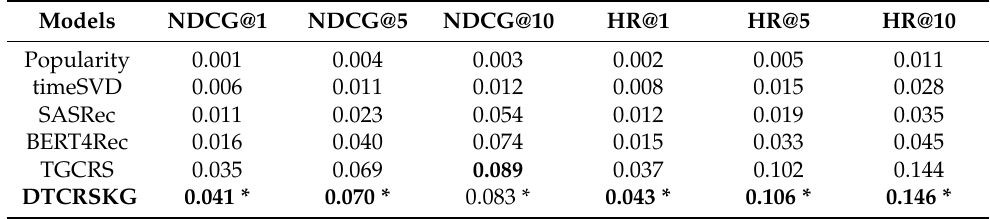
Table 2. Experimental results of performance comparison using the CwConvRec dataset. Models